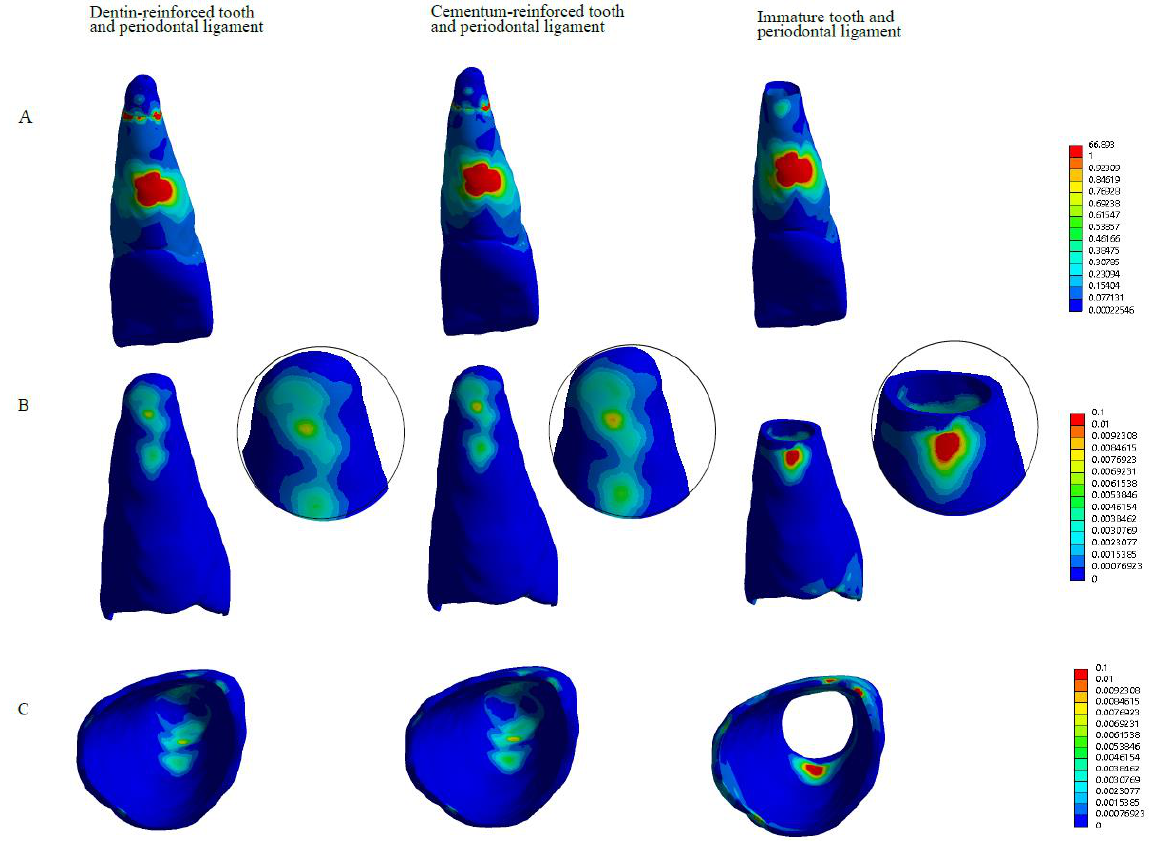
Figure 4. Stress distribution in the tooth ( A ) and in the periodontal ligament ( B , C ) of Models 1, 2 and 3 in palatal inclination scenario. Similar stress patterns are observed between all tissues of Models 2 and 3. Maximum tensile stress of the teeth ( A ) and ligaments ( B , C ) are coloured in red. In the dentine-reinforced tooth and cementum-reinforced tooth, the highest values of tensile stress in the periodontal ligament were located at the apical third, while for the immature tooth, it was located at the apical and coronal third in the palatal